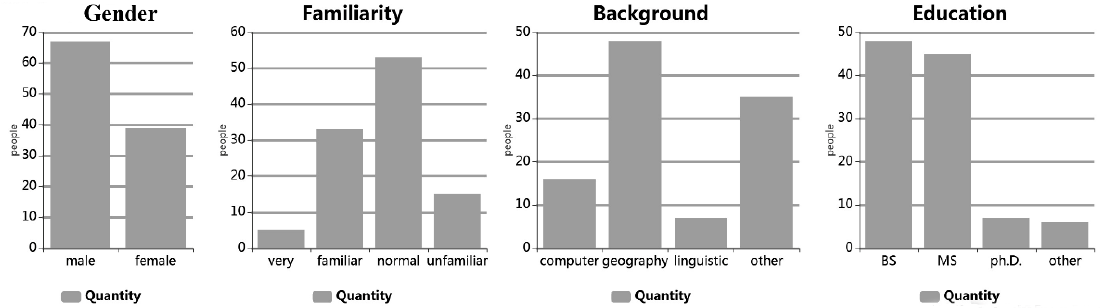
Figure 9. The statistics of the four main types of the basic information about the survey.